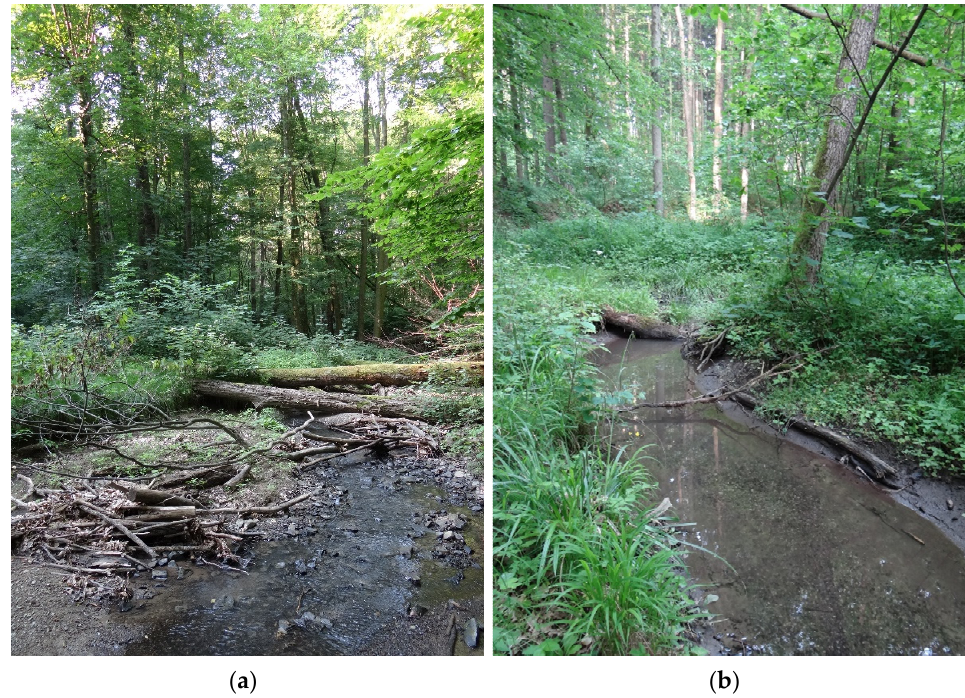
Figure 4. Habitat of Cordulegaster heros in the Czech Republic: ( a ) locality of Habeššký potok stream (Kostelany cadastral territory, southern Czech Republic) (locality VIe) (18 July 2013, photo Otakar Holuša), ( b ) locality of Cvr č ovický potok stream (Cvr č ovice cadastral territory, southern Czech Republic) (locality Id) (4 June 2016, photo Otakar Holuša).